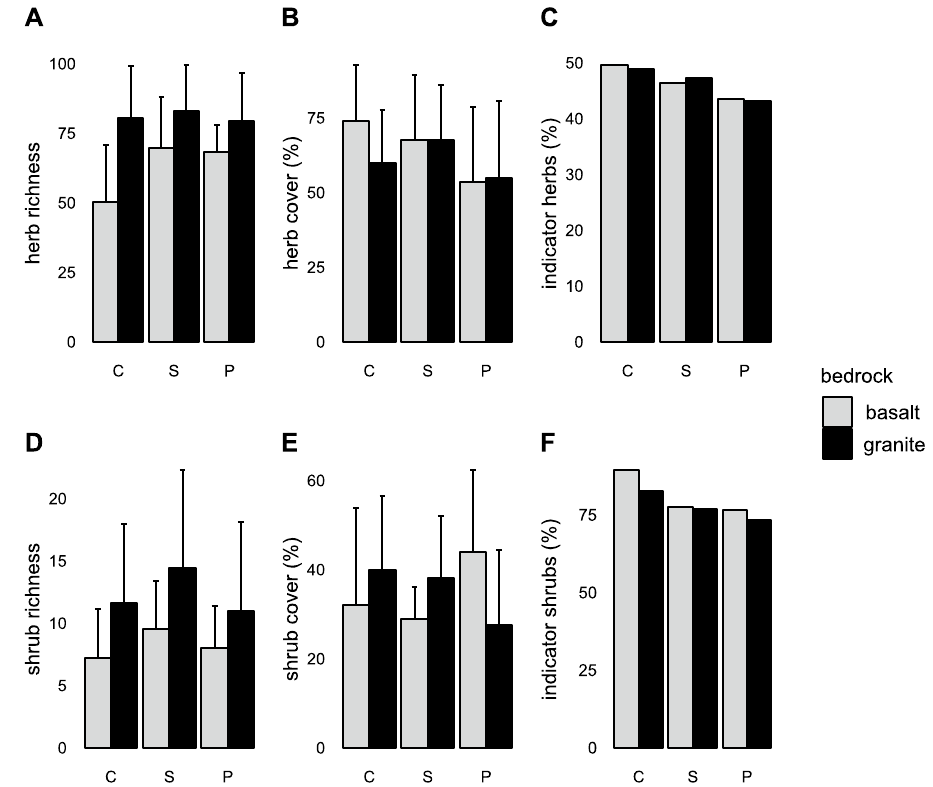
Figure 5. Plant species richness, cover, and share of indicator species of herbs and shrubs on three plot types— crests (C), seasonal rivers (S), and perennial rivers (P) and on two types of bedrocks (granite and basalt). Bars show means for each type of bedrock and habitat combination (n = 10), and error bars show associated standard deviation (SD).